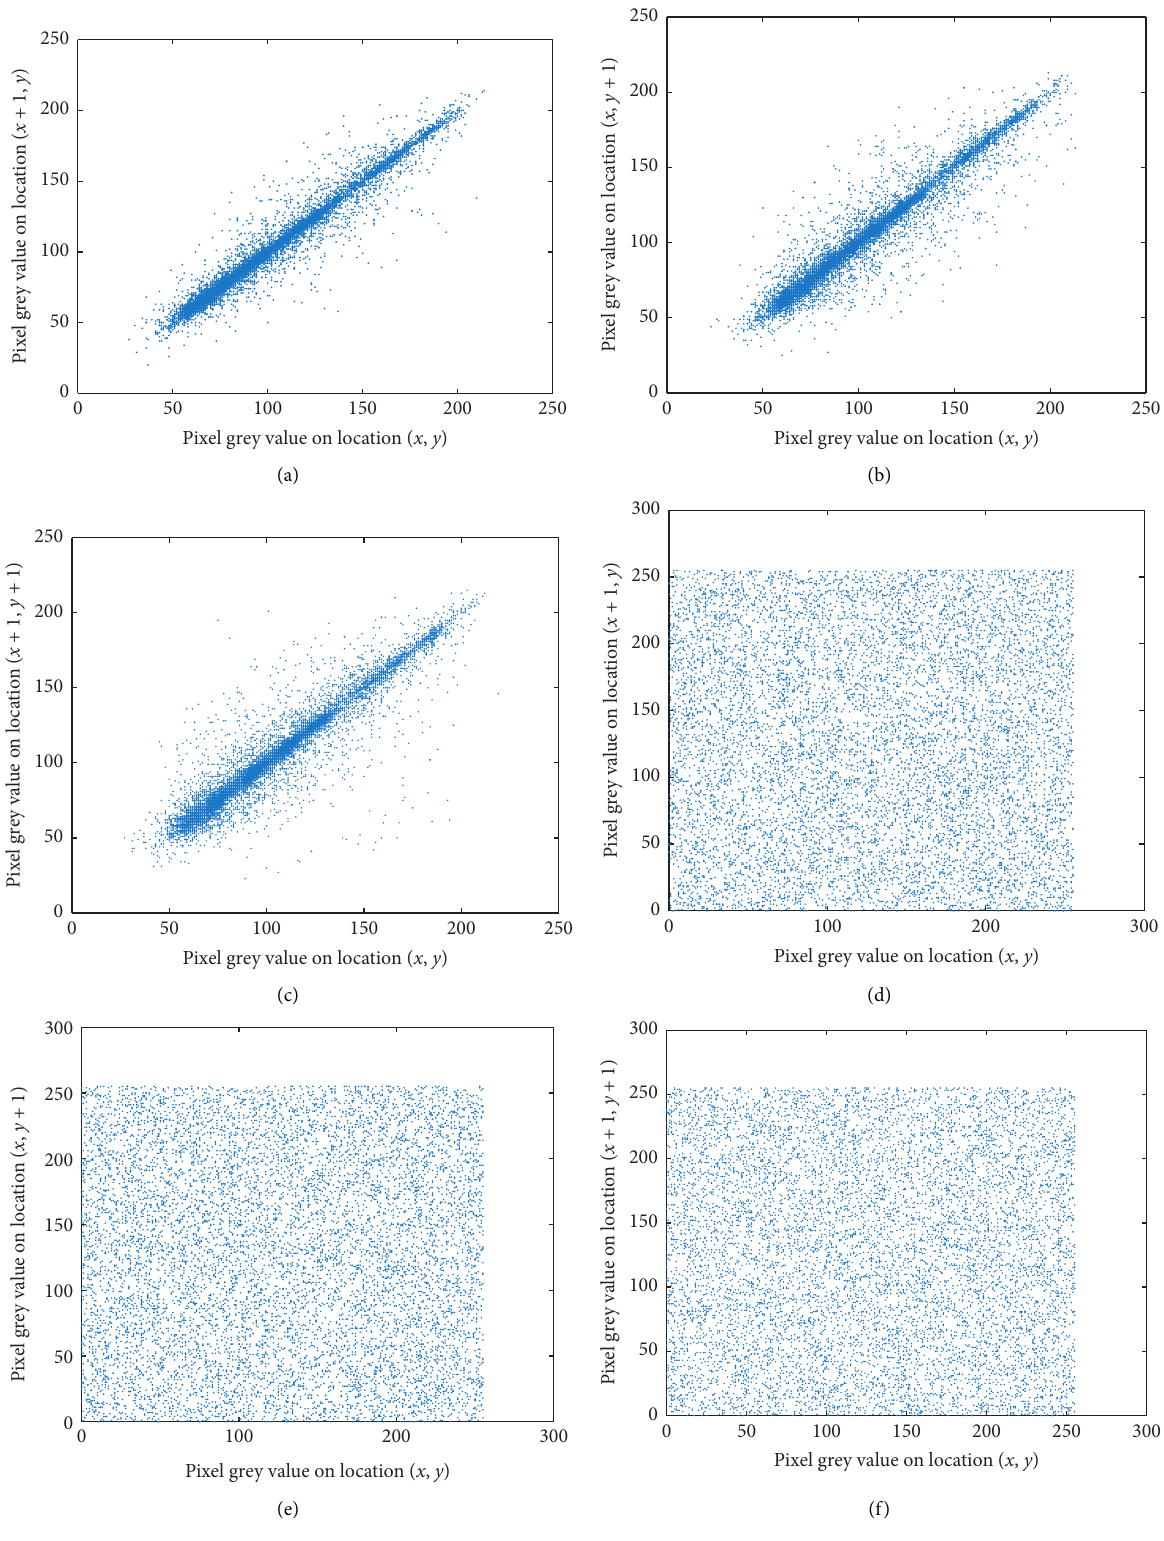
Figure 11: The correlation plots of two adjacent pixels for plaintext and ciphertext. (a) Horizontal correlation of plaintext; (b) vertical correlation of plaintext; (c) diagonal correlation of plaintext; (d) horizontal correlation of ciphertext; (e) vertical correlation of ciphertext; (f) diagonal correlation of